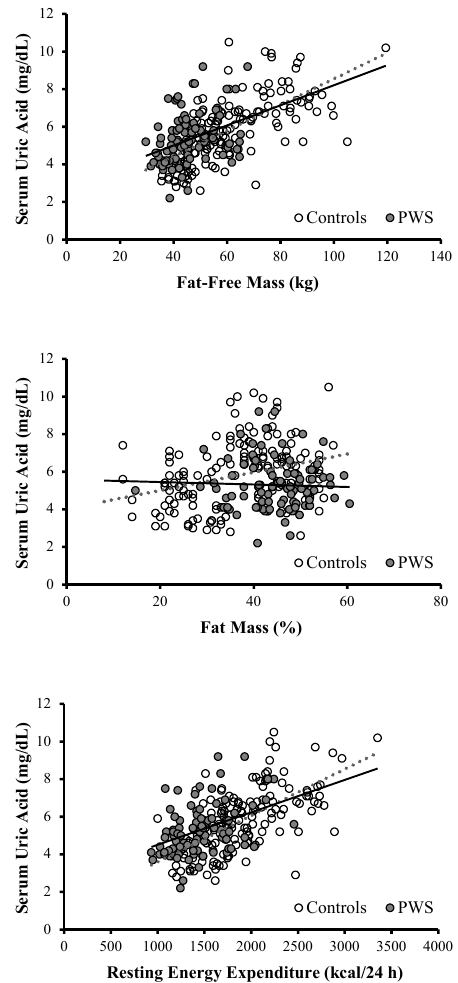
Figure 2. Bivariate correlation analysis between serum UA levels and resting energy expenditure (upper panel), fat-free mass (middle panel), and fat mass (lower panel). Closed circles and closed line: patients with PWS; open circles and dashed line: control subjects.